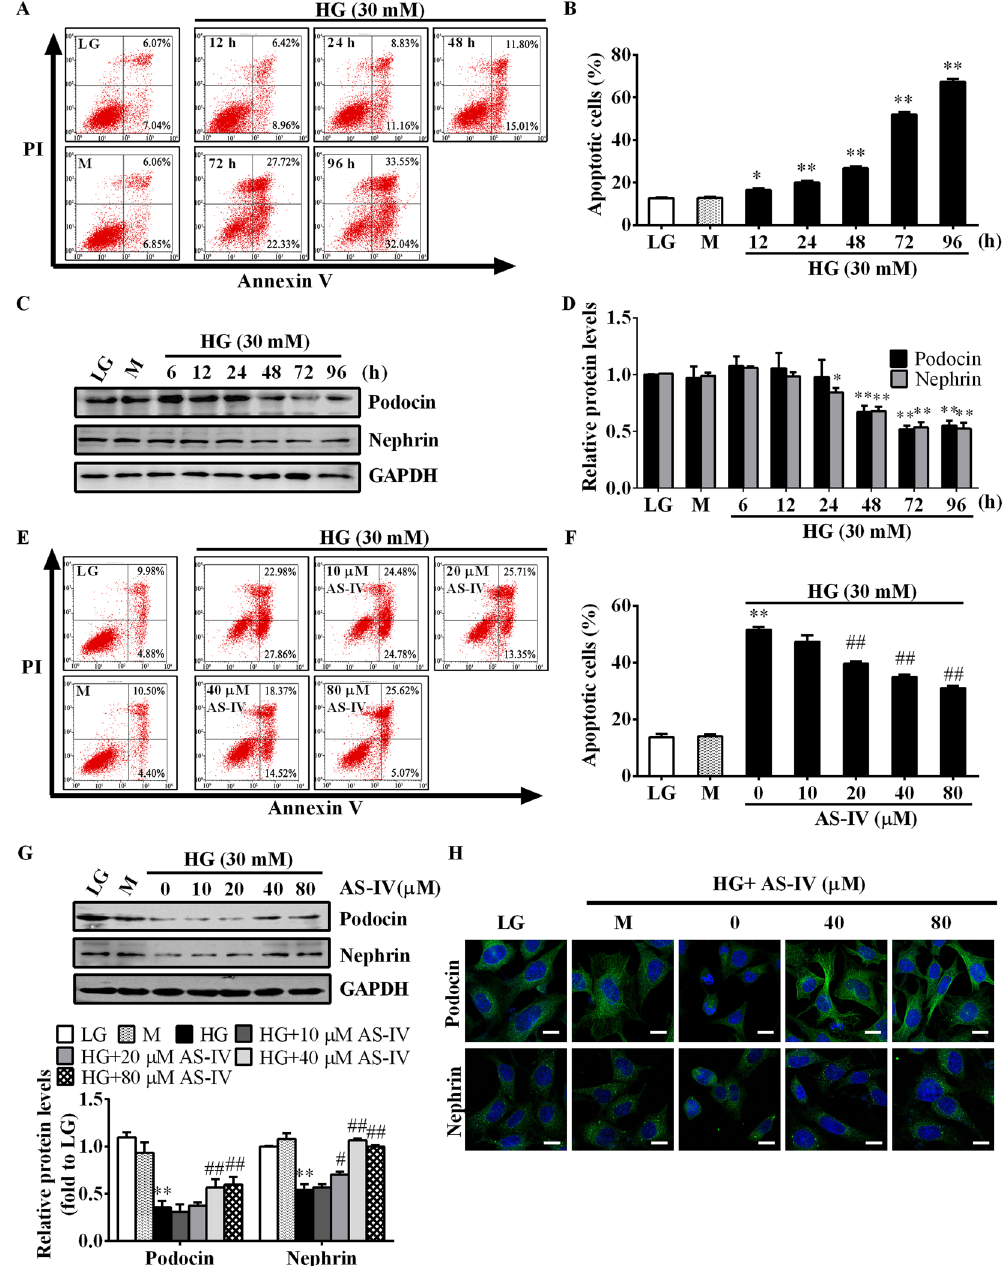
Figure 5. AS-IV reduced HG-induced podocyte apoptosis. ( A – D ) Podocytes were treated with 30 mM HG for 6, 12, 24, 48, 72 and 96 h. LG and M were used as controls. Podocytes were collected at different time points and subjected to analyses by flow cytometry or western blot. ( A ) Representative flow cytometry results for podocytes exposed to HG for various time periods as indicated. ( B ) Quantitative analysis of apoptotic cells determined by flow cytometry. ( C , D ) Western blot analyses ( C ) and densitometric quantification ( D ) of Podocin and Nephrin expression at various time points. Data are expressed as mean ± SEM. n = 3. * P < 0.05, ** P < 0.01 compared to LG group. ( E – H ) Podocytes were pretreated with or without AS-IV at the indicated concentrations for 2 h followed by HG exposure for 72 h and then subjected to analyses by flow cytometry, western blot and immunofluorescence staining. ( E , F ) Representative flow cytometry pictures ( E ) and quantitative analysis ( F ) of apoptotic podocytes under different cultural conditions. ( G ) Western blot analyses and densitometric quantification of Podocin and Nephrin expression under different cultural conditions. ( H ) Immunofluorescence staining for Podocin and Nephrin under different cultural conditions. It revealed crimpled Podocin around the nuclei and reduced Nephrin expression. Scale bars, 10 μ m. The original blots for panel C and G were presented in Supplementary Figure S6. Data are expressed as mean ± SEM. n = 3. ** P < 0.01 compared to LG group. # P < 0.05, ## P < 0.01 compared to HG group. One-way ANOVA and Newman-Keuls multiple comparisons test ( B , D , F , G ). LG, low glucose; M, mannitol; HG, high